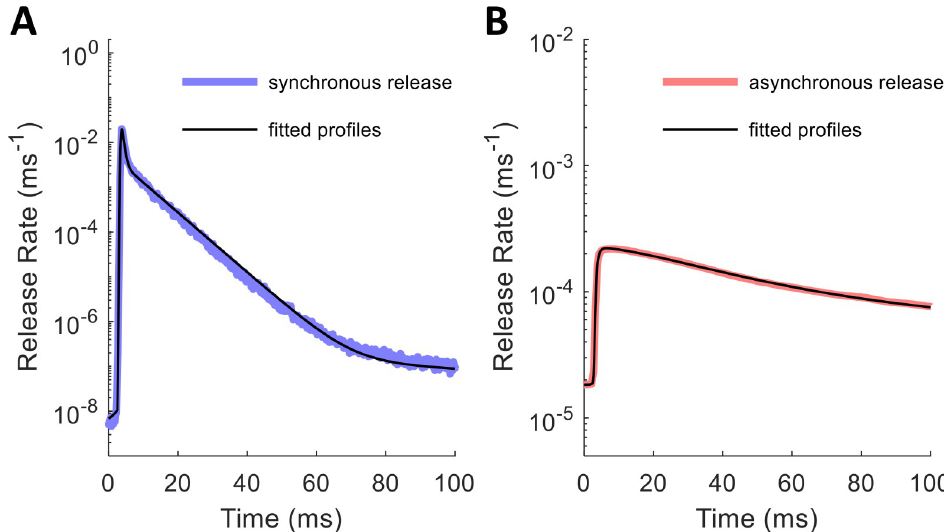
Fig 7. Fitted Release Rate Histogram Profiles for a Single Spike. Parameter values given in Table 2. (A) Synchronous release rate: true histogram (blue) with estimated histogram (black). (B) Asynchronous release rate: true histogram (red) with estimated histogram (black).